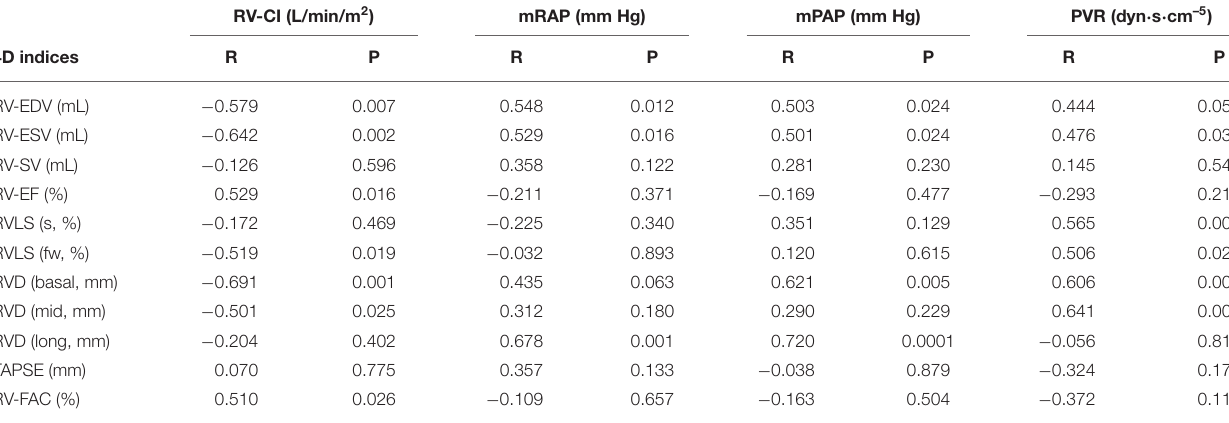
TABLE 4 | Correlation between RHC and 4D auto-RVQ indices in the high-quality image PHTN group ( n = 24).